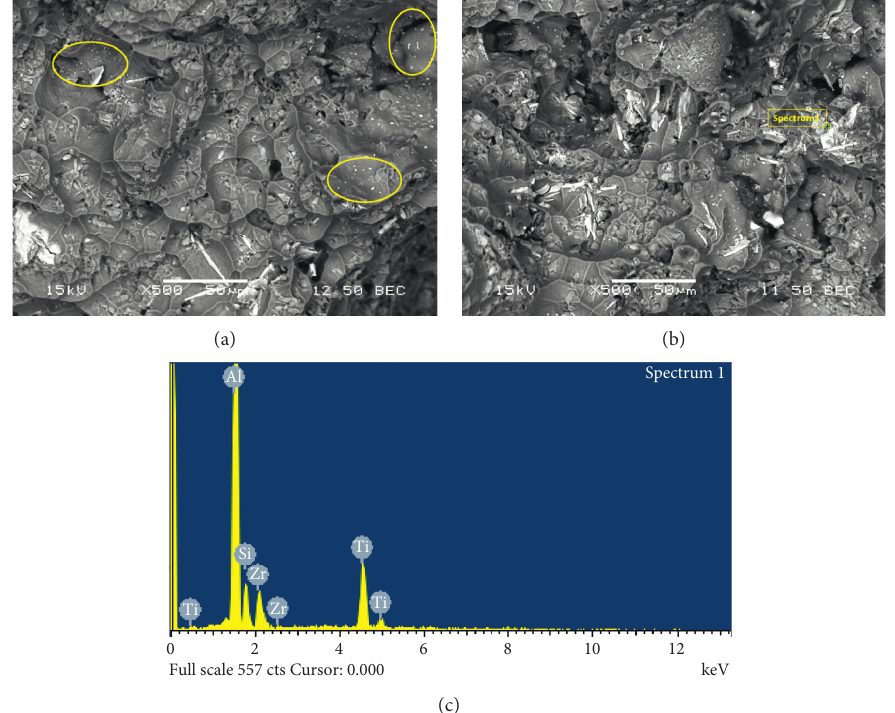
Figure 4: (a), (b) BSE images of T6-treated M1S alloy after stabilization at 250 ° C for 200 hours showing a coarse dimpled structure, coarsened precipitates, and Al x (Zr, Ti)Si particles involved in the crack initiation process and (c) corresponding EDS spectrum of the phase of interest shown in